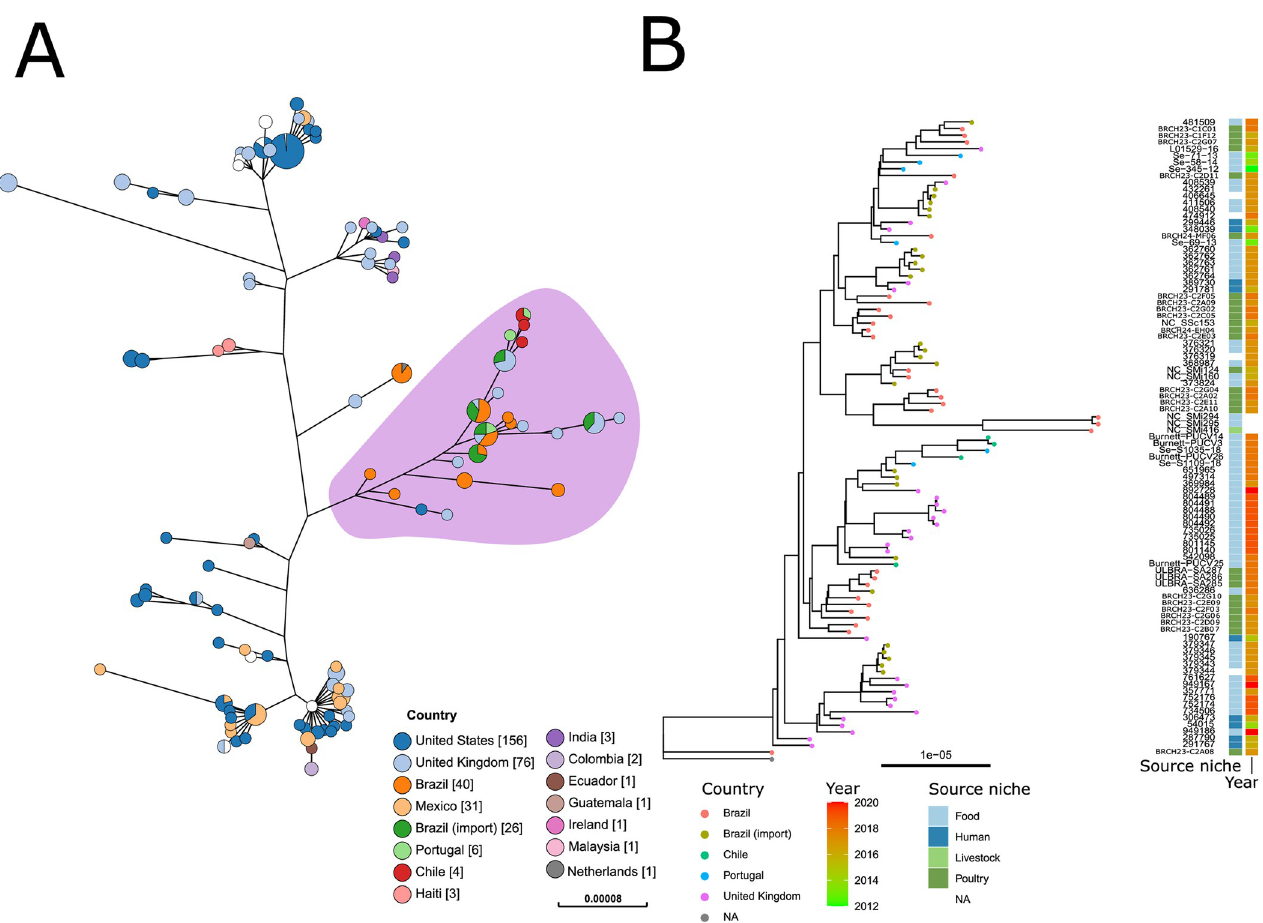
Fig 3. Phylogeny of Salmonella Minnesota. (A) Maximum likelihood phylogenetic tree of Salmonella Minnesota genomes, including isolates from Brazil, imported chicken meat from Brazil, and representatives from the rest of the world. Nodes are coloured by country of origin as indicated in the key. An interactive version of this figure with supporting metadata is available at https://microreact.org/project/brch-3a (B) Maximum likelihood phylogenetic tree of genomes highlighted in lilac in part A. Tips were colour coded according to sample origin. Inner ring indicates the source niche. Outer ring indicates the collection year. An interactive version of this figure with supporting metadata is available at https://microreact.org/project/brch3b.